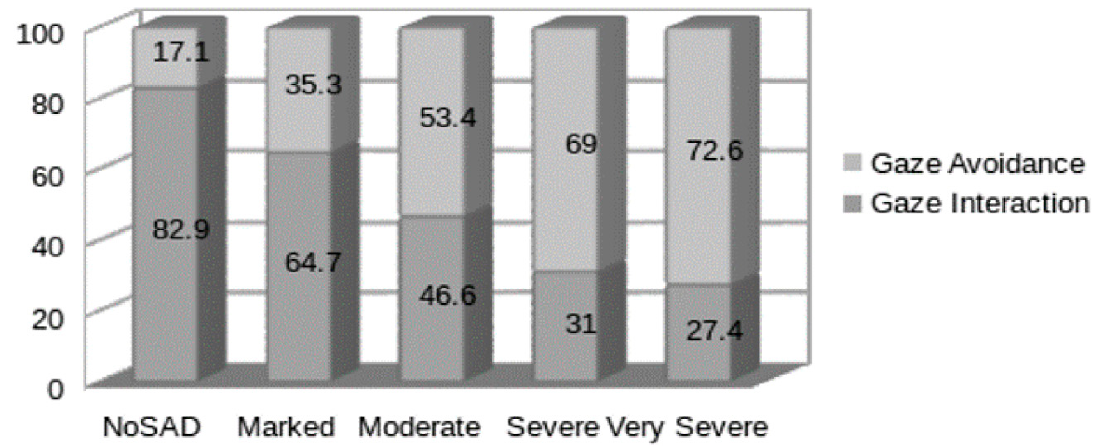
Figure 5. Overall view of gaze interaction and SAD relationship.